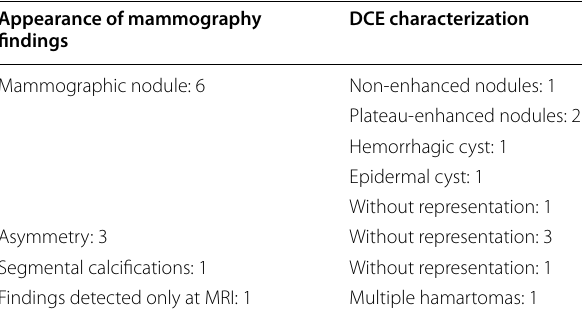
Table 8 Mammography findings versus DCE characterization